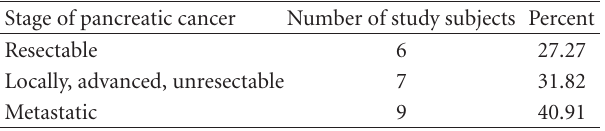
Table 2: Stage of pancreatic